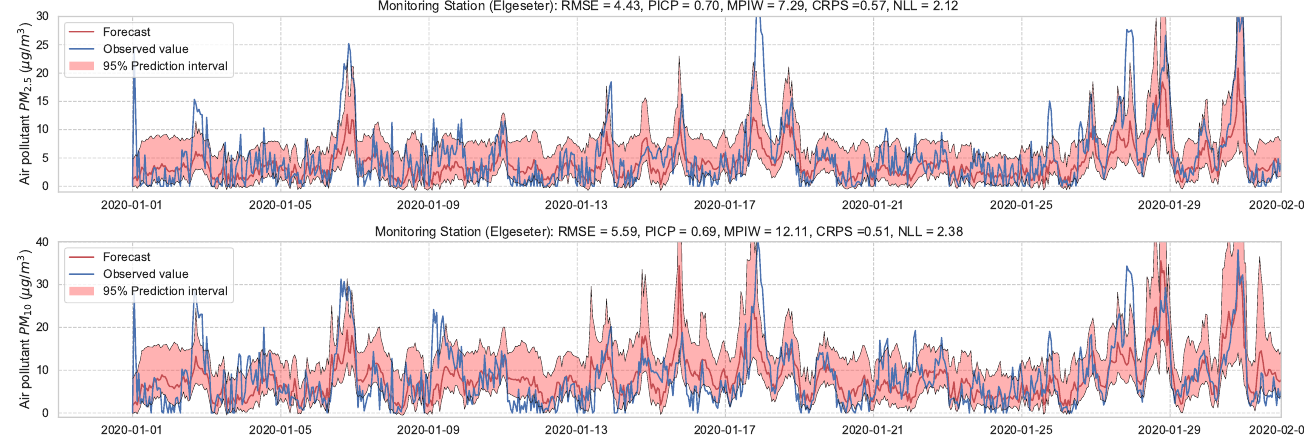
Figure 13. Probabilistic forecasting of multivariate time-series air quality using a standard neural network model with MC